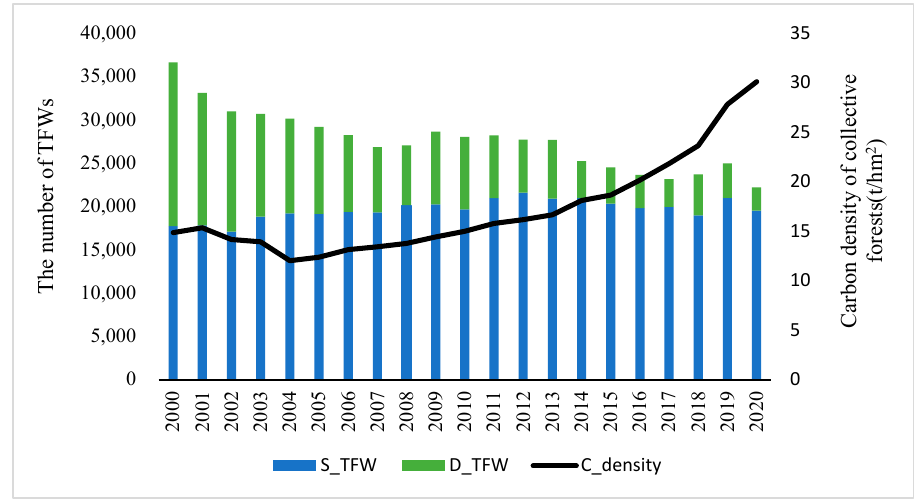
Figure 2. The evolution of TFW and collective forest carbon density from 2000 to 2020 (n = 651).